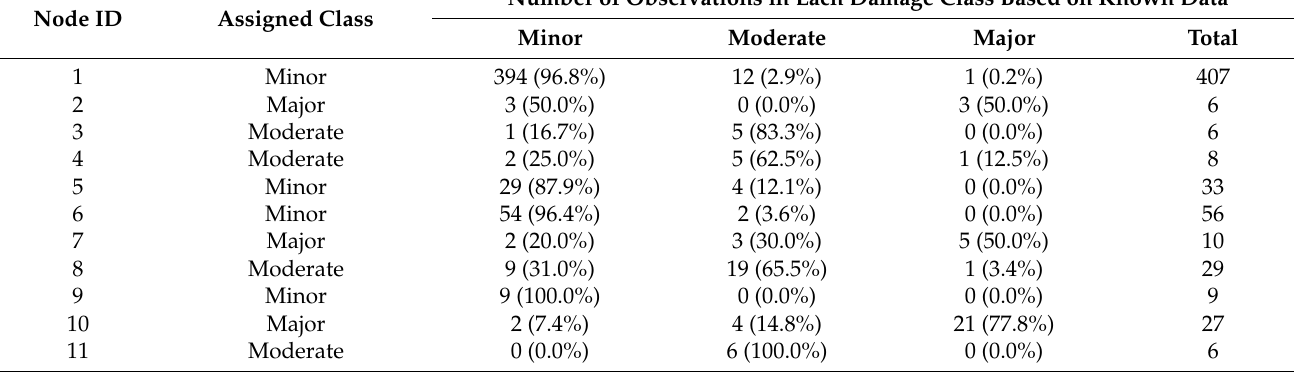
Figure 7. Pruned classification tree with custom misclassification cost matrix ( c = 2). Predictor parameters and the associated values used to split nodes are defined in the black diamonds and extending arrows. Terminal nodes are represented by blue, yellow, and red rectangles. At each terminal node, both the associated damage class and node ID are defined. Table 4. Node statistics for pruned classification tree.